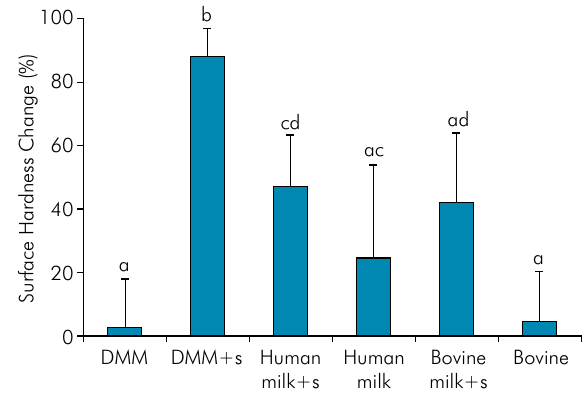
Figure 1. Surface hardness change (%) and standard deviation (SD) according to the growth condition of biofilms. Distinct letters indicate significant difference among groups (p < 0.05).